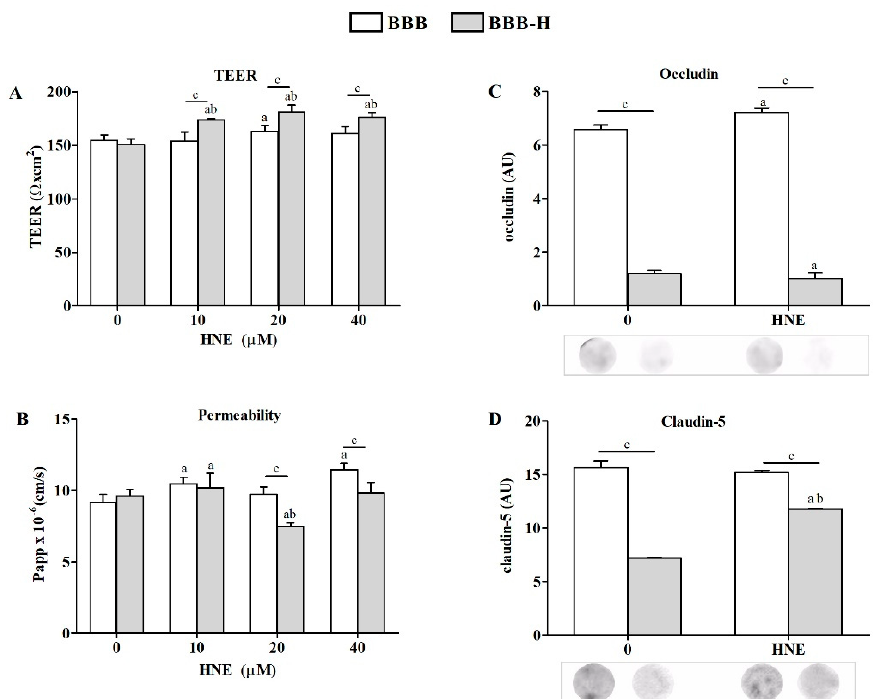
Figure 3. Markers of BBB integrity and permeability measured on BBB and BBB-H model. ( A ) TEER values of both models under HNE treatment (0, 10, 20, 40 µ M). ( B ) Permeability of sodium fluorescein for both BBB models under HNE treatment (0, 10, 20, 40 µ M). ( C ) Occludin and ( D ) claudin-5 changes in RbE4 cells of both BBB models at control conditions (0) and 20 µ M HNE treatment, assessed by dot-blot. Signal intensities were analyzed with NIH ImageJ and represented as arbitrary units (AU). All results are represented as mean ± SD, n = 12 samples for each group from 4 independent